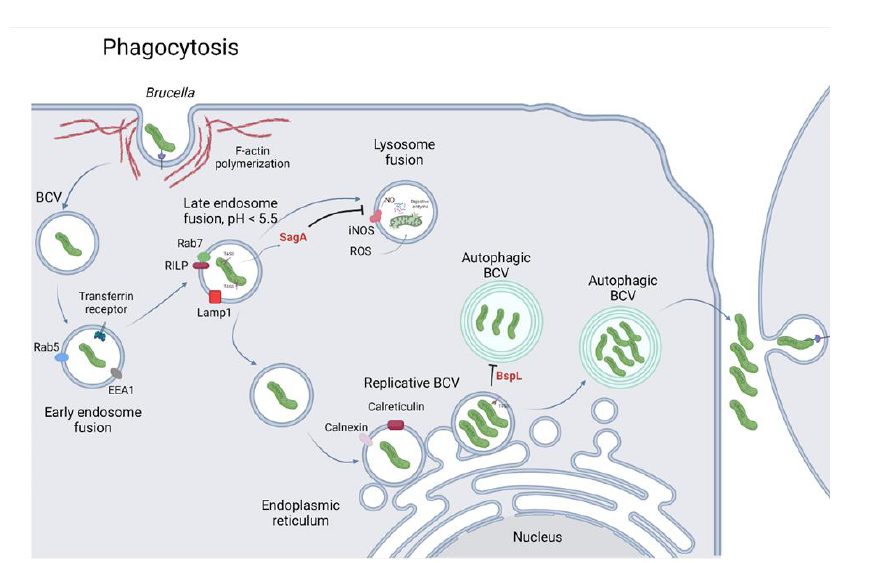
Figure 2. Intracellular trafficking cycle of Brucella in host cells. After recognizing Brucella by different receptors, host cells activate the signaling pathway resulting in F-actin polymerization at the binding site with bacteria. Then the BCVs undergo fusion with early, late endosome, and finally lysosome. At the last phase of BCVs’ maturation, Brucella is killed by nitric oxide, ROS, and digestive enzymes that localize in the phagolysosome compartment. However, Brucella has the ability to avoid the phagolysosome fusion to reach its intracellular niche at ER. Brucella SagA protein is secreted to interfere with the interaction between BCVs and lysosomes. Once localizing in ER, Brucella can proliferate and mature into aBCVs. This aBCVs formation depends on distinct autophagy proteins including ULK1 and Beclin 1, which contribute to bacterial egress and the formation of infection foci resulting in dissemination to other cells and tissues. Besides, Brucella activates a T4SS-BspL effector to delay the formation of aBCVs, and ultimately reach maximum proliferation.